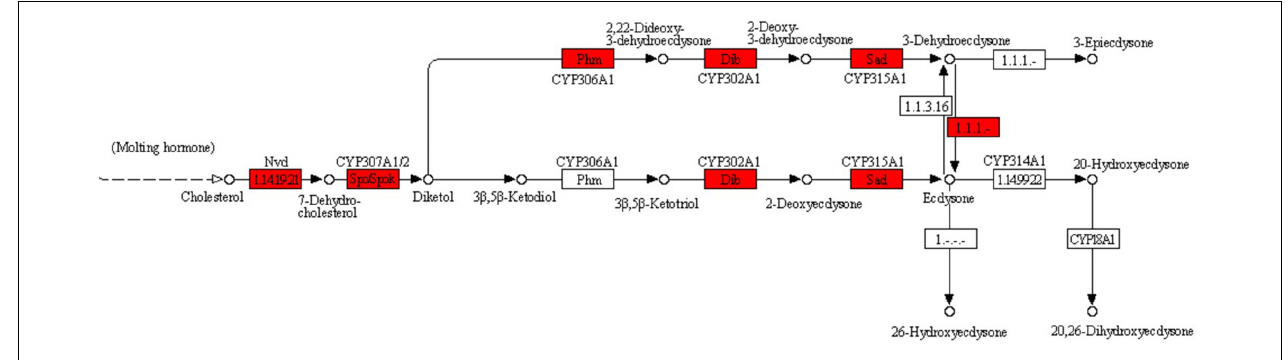
FIGURE 5 | Pathway for synthesizing ecdysone from cholesterol. Red-labeled enzymes (encoded by nvd , spo , spok , dib , and sad ) are found in Y-organ genome-scale metabolic network (GSMN), while the phm -related reaction R08136 was added to the network during the gap filling process.